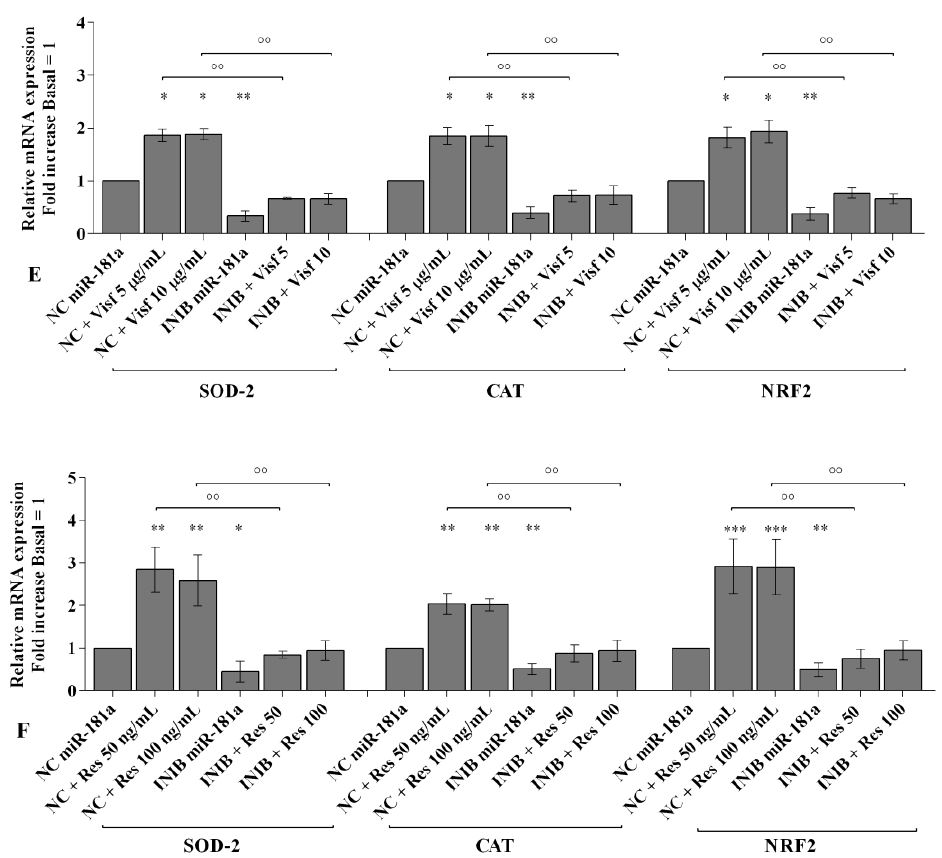
Figure 8. ( A , C , D ) Mitochondrial superoxide anion production was assessed by flow cytometry using MitoSox Red staining. ( B , E , F ) Expression levels of superoxide dismutase ( SOD-2 ), catalase ( CAT ), nuclear factor erythroid 2 like 2 ( NRF2 ) by real-time PCR. Human osteoarthritic (OA) synovial fibroblasts were evaluated at basal condition, after 24 h of transfection with miR-181a inhibitor or NC, and after incubation with visfatin (5 and 10 μg/mL) and resistin (50 and 100 ng/mL). The superoxide anion production and the gene expression were referenced to the ratio of the value of interest and the value of basal condition (basal, cells without treatment) or NC reported equal to 1. Data were expressed as mean ± SD of triplicate values. * p < 0.05, ** p < 0.01, *** p < 0.001 versus basal condition or NC. ° p < 0.05, °° p < 0.01 versus inhibitor. INIB= inhibitor, NC= negative control siRNA, Visf= visfatin, Res = resistin.